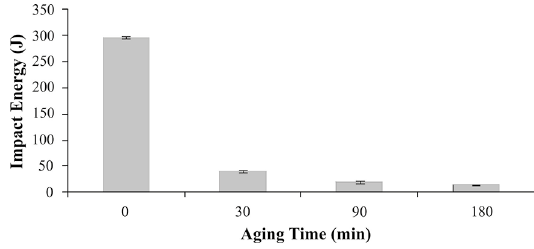
Figure 7. Charpy impact energy as a function of ageing time at 830 ºC.